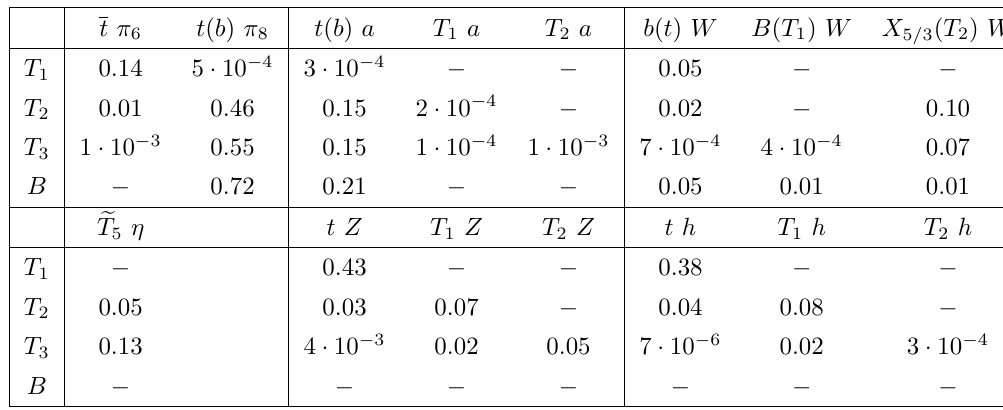
Table 3 . Branching ratios of the VLQs in the benchmark scenario Bm3 for (cid:12)xed values of the coloured PNGBs masses, m (cid:25) = m (cid:25) = 800 GeV while m a = m (cid:17) = 100 GeV. The other conventions 6 8 are the same as in table 1.